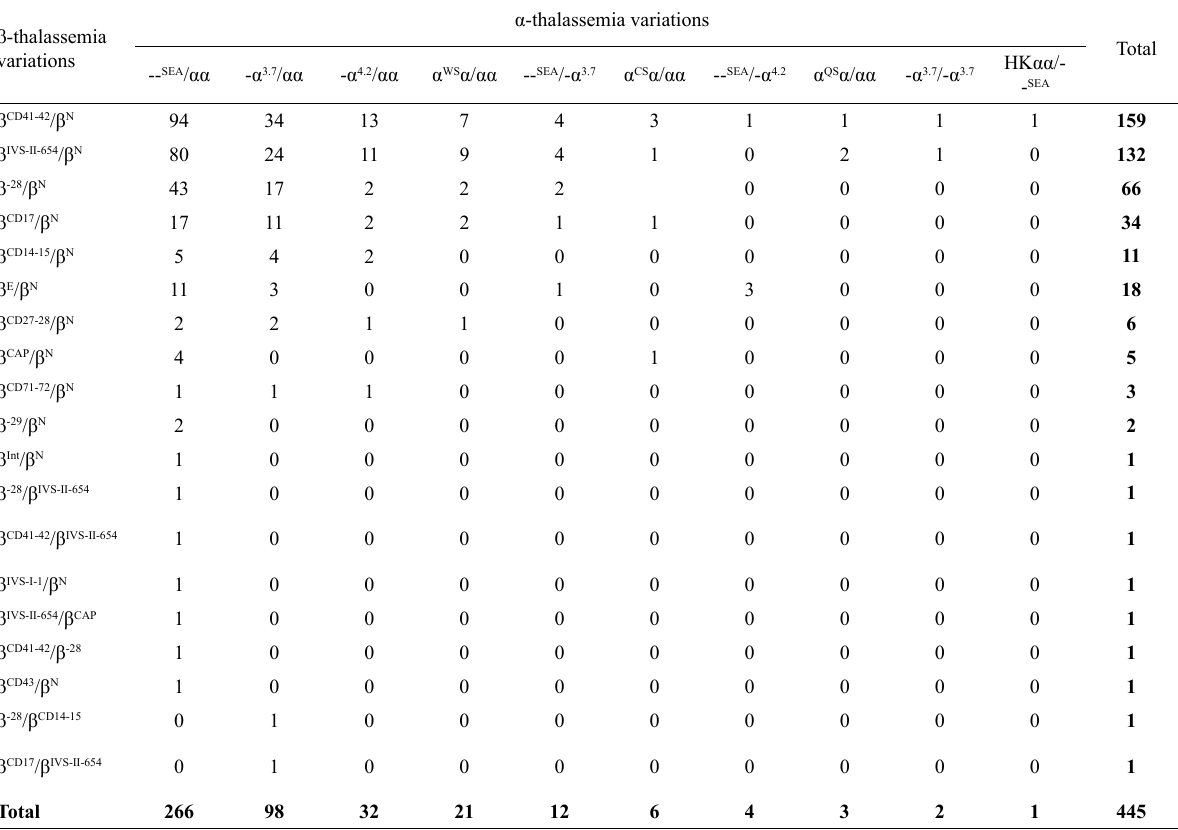
Table 3 – Distribution of composite α-thal and β-thal in